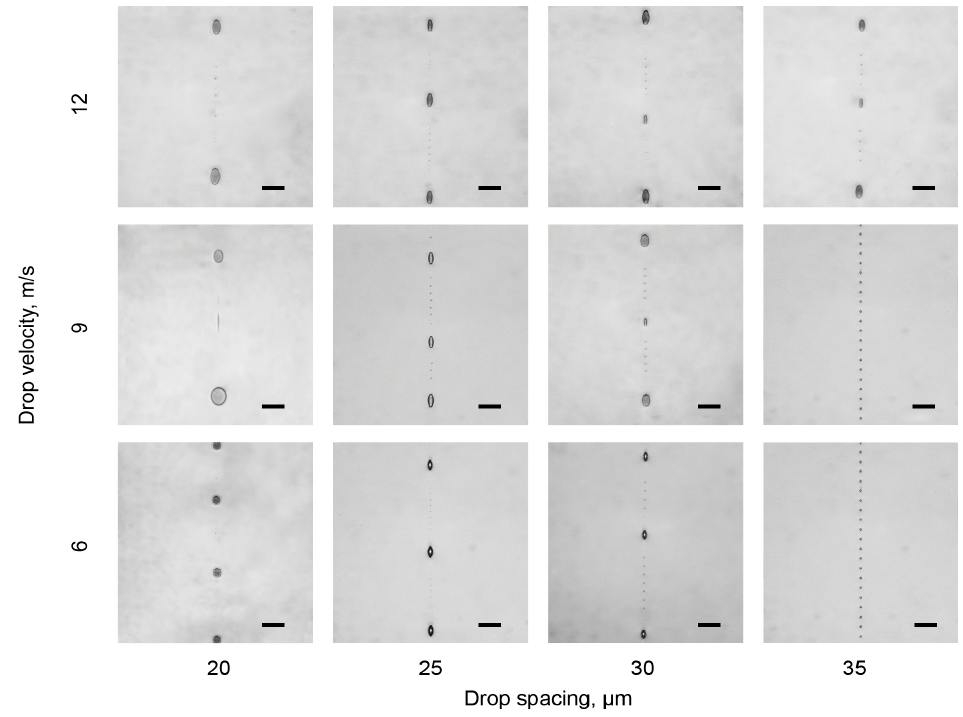
Figure A2. Array of optical images of a 1 pxl line printed on PDMS when cured for 3 min at 80 °C depending on drop spacing and velocity. The scale bar is 100 µm.